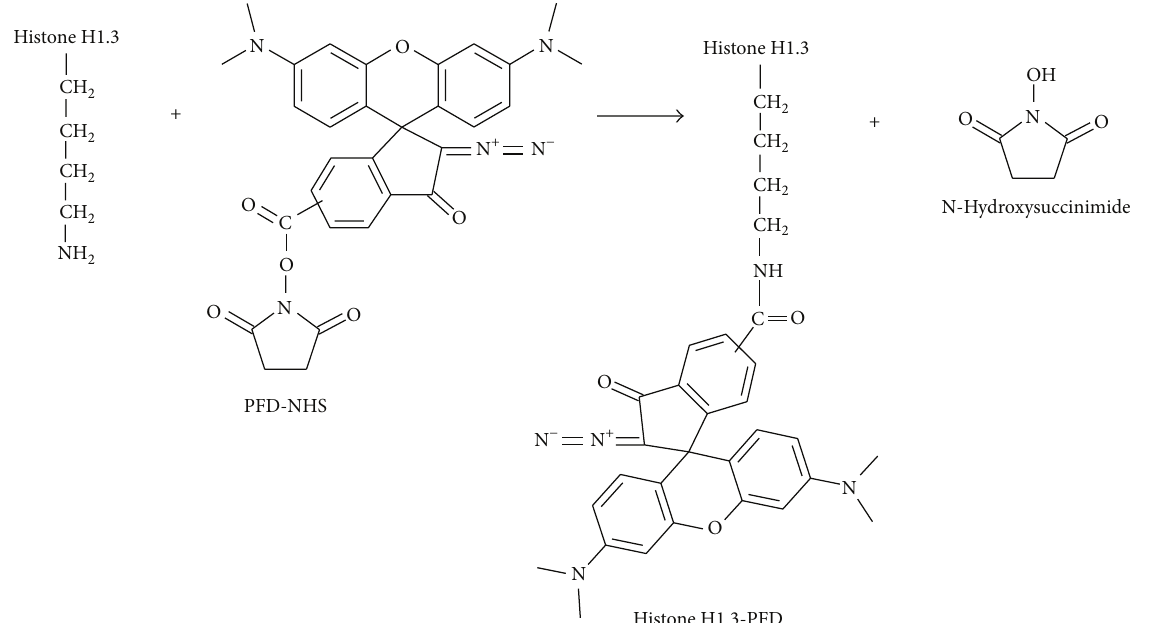
Figure 2: Scheme of the conjugate of histone H1.3 with PFD (“Histone H1.3-PFD”) synthesis.